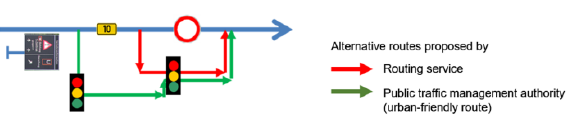
Figure 1. Divergent routes proposed by routing service and public traffic management